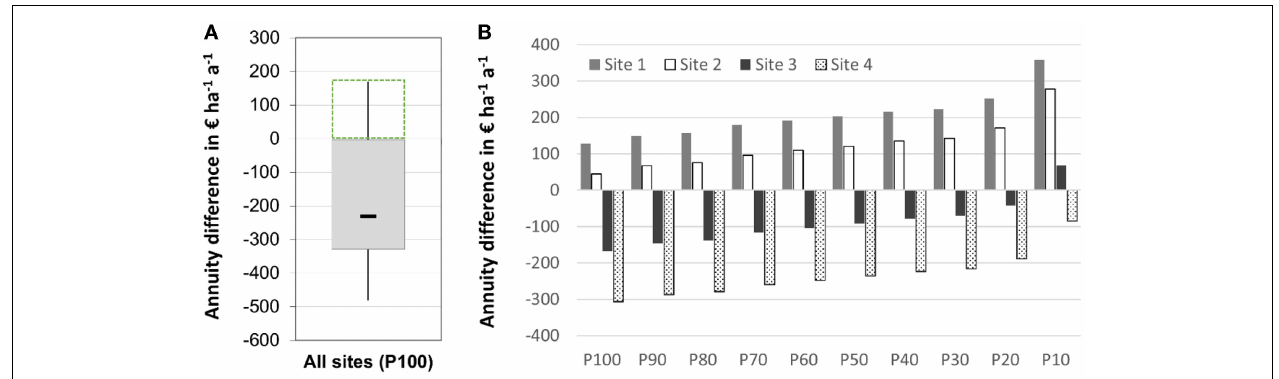
indicates the sites with a positive annuity difference as shown in more detail in Figure 7A, and (B) probability related annuity differences for exemplary sites to illustrate “probability profiles” of economic return (P10–P100 illustrate the percentiles of probability) .